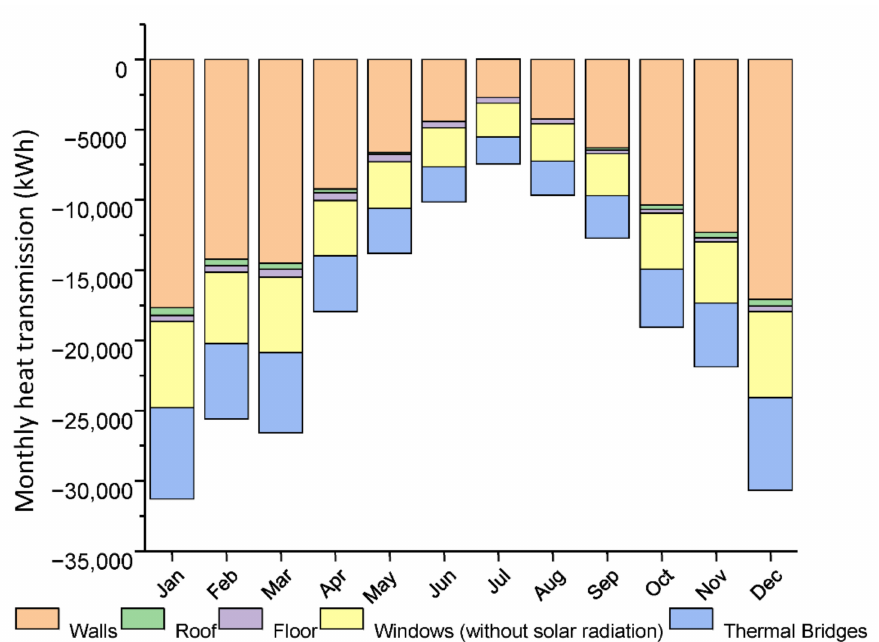
Figure 17. Monthly heat transmission (only sensible heat) through the envelope for case B (with low-E